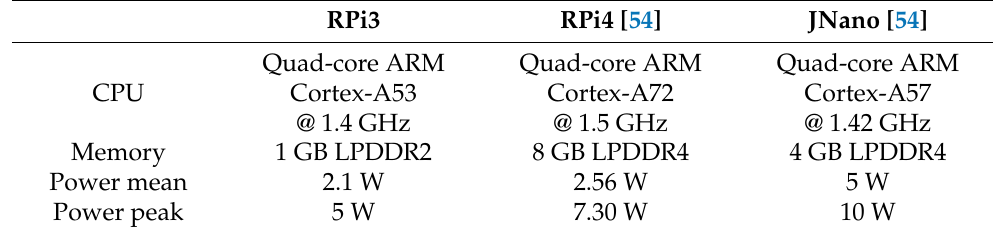
Table 1. Specifications of the selected